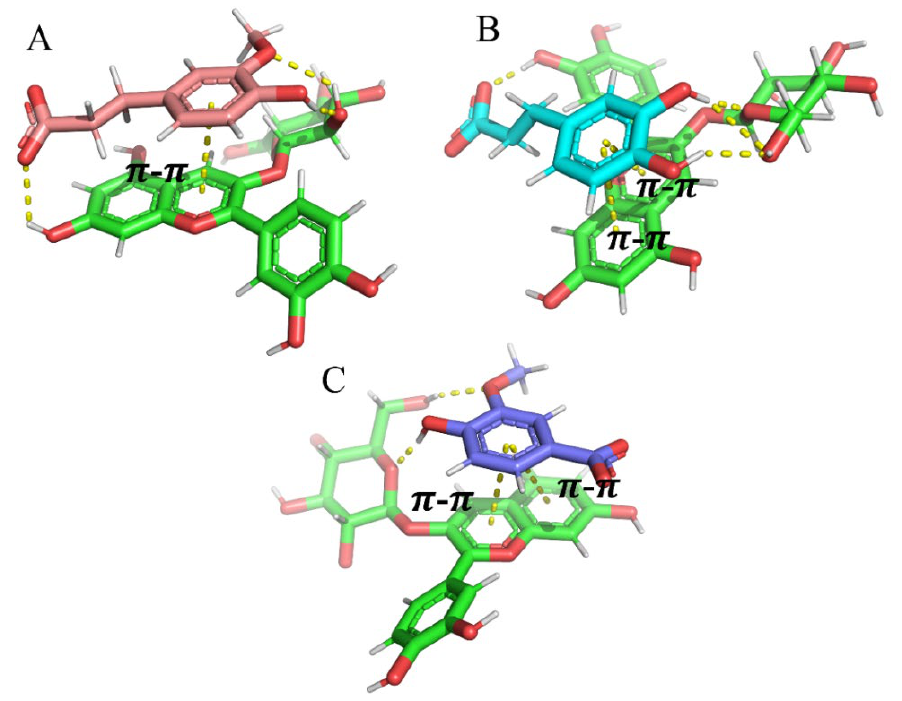
Figure 10. Molecular dynamic simulation obtained between C3G and three organic acids (( A ) FA-C3G, ( B ) CA-C3G, ( C ) VA-C3G).